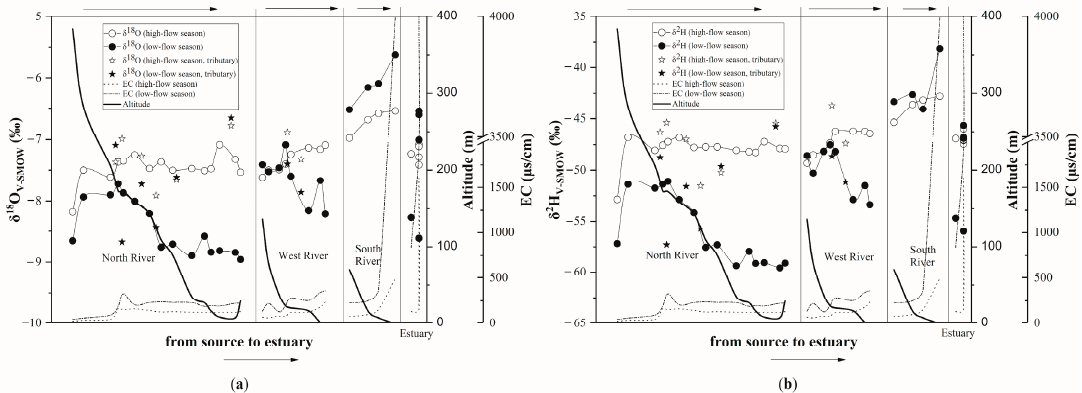
Figure 3. O ( a ) and H ( b ) isotope composition of all samples in different